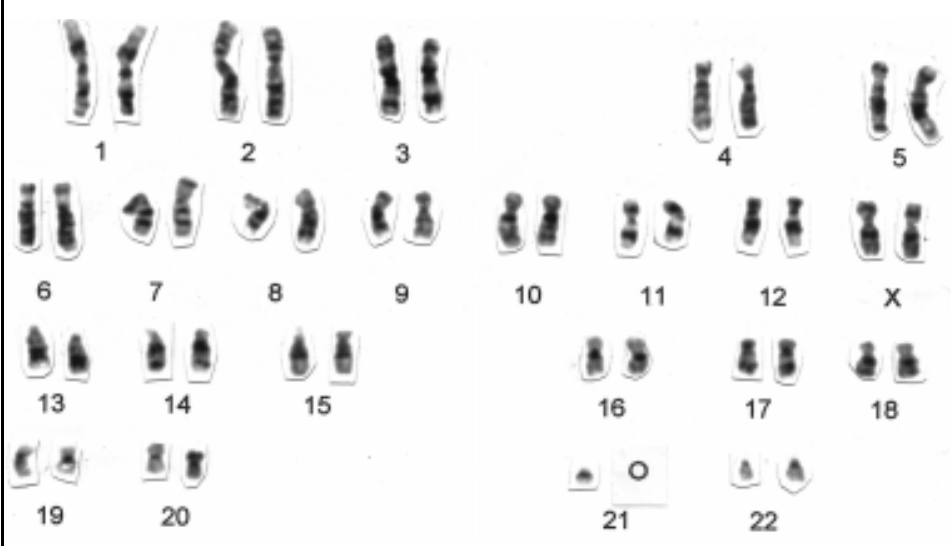
Figure 1. G-banded karyotype: 45,XX; -21 (case